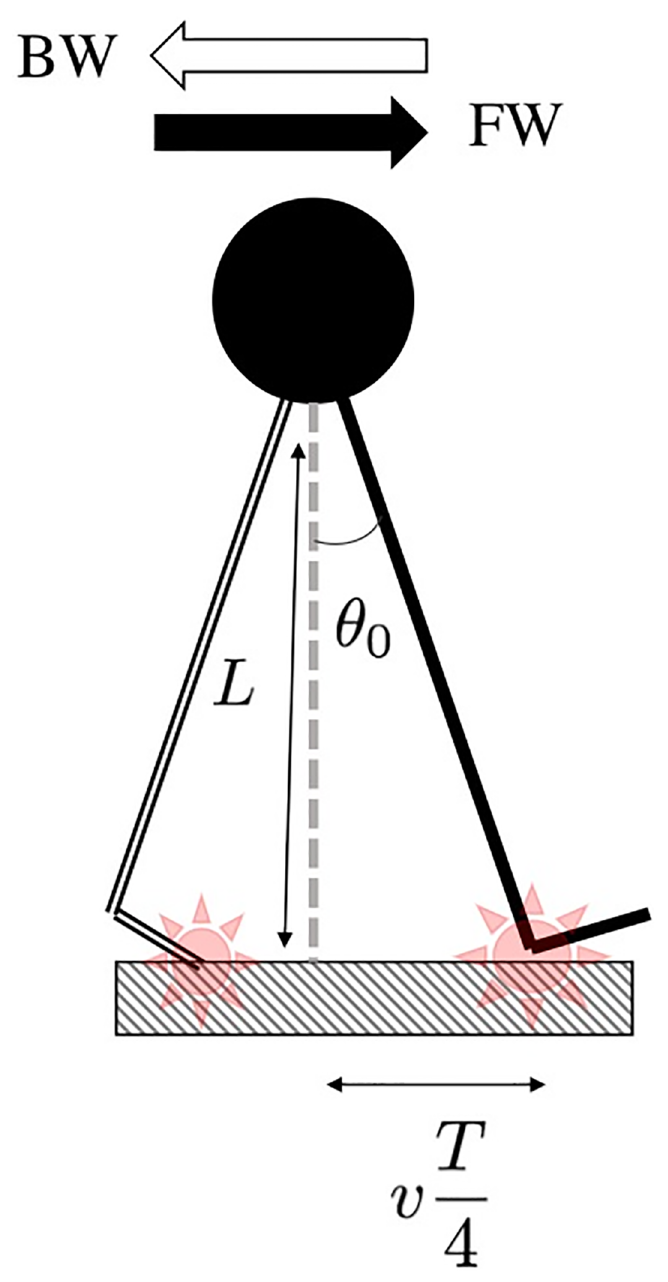
Fig 3. Schematic representation of the body (circle) and the lower limb (solid lines) when the heel strikesthe ground in forward direction (FW) or the toes in backward direction (BW). The red star enclosesthe contact